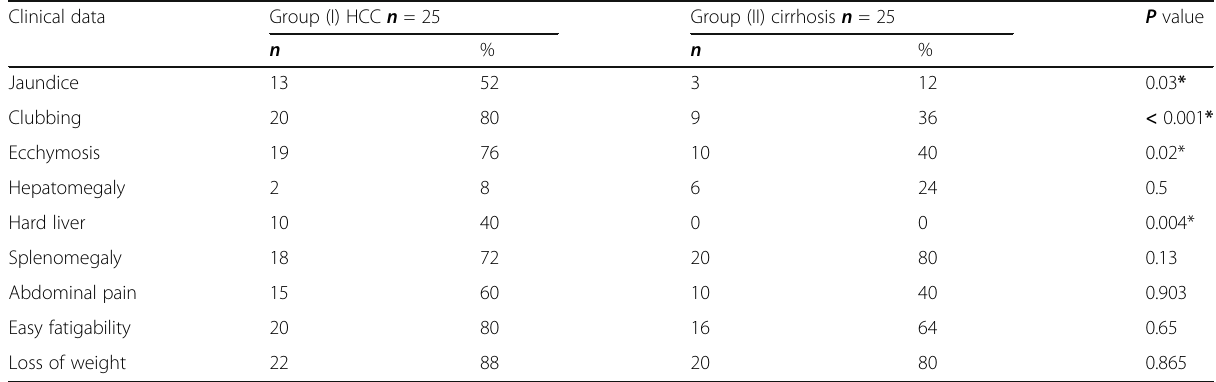
Table 2 Comparison between the studied groups according to clinical data Clinical data